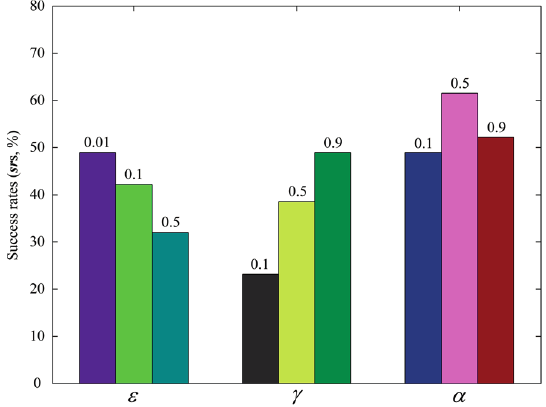
Figure 11. Success rates of the Track-Out activities in ten CPT runs obtained using different values of ε , γ , and α . The tested values are displayed on top of the